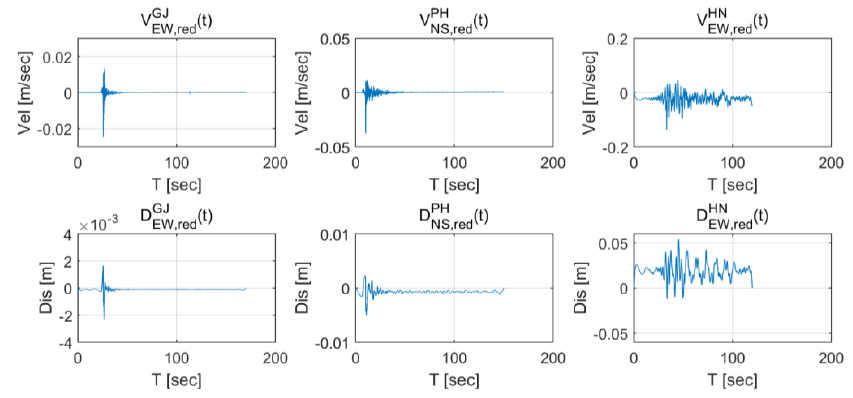
Figure 6. Adjusted earthquake data used for the study. The Gyeongju and Hachinohe earthquakes ( far left and far right , respectively) are in the east-west direction. The Pohang ( center ) earthquake is in the north-south direction.